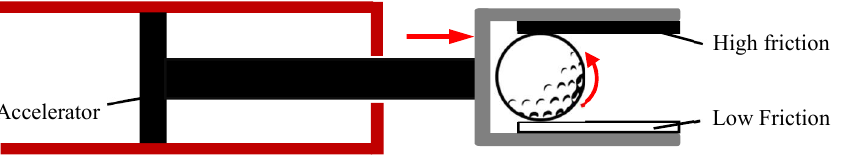
Figure 1. Setup on pitch machine to generate back spin on pitching machine.